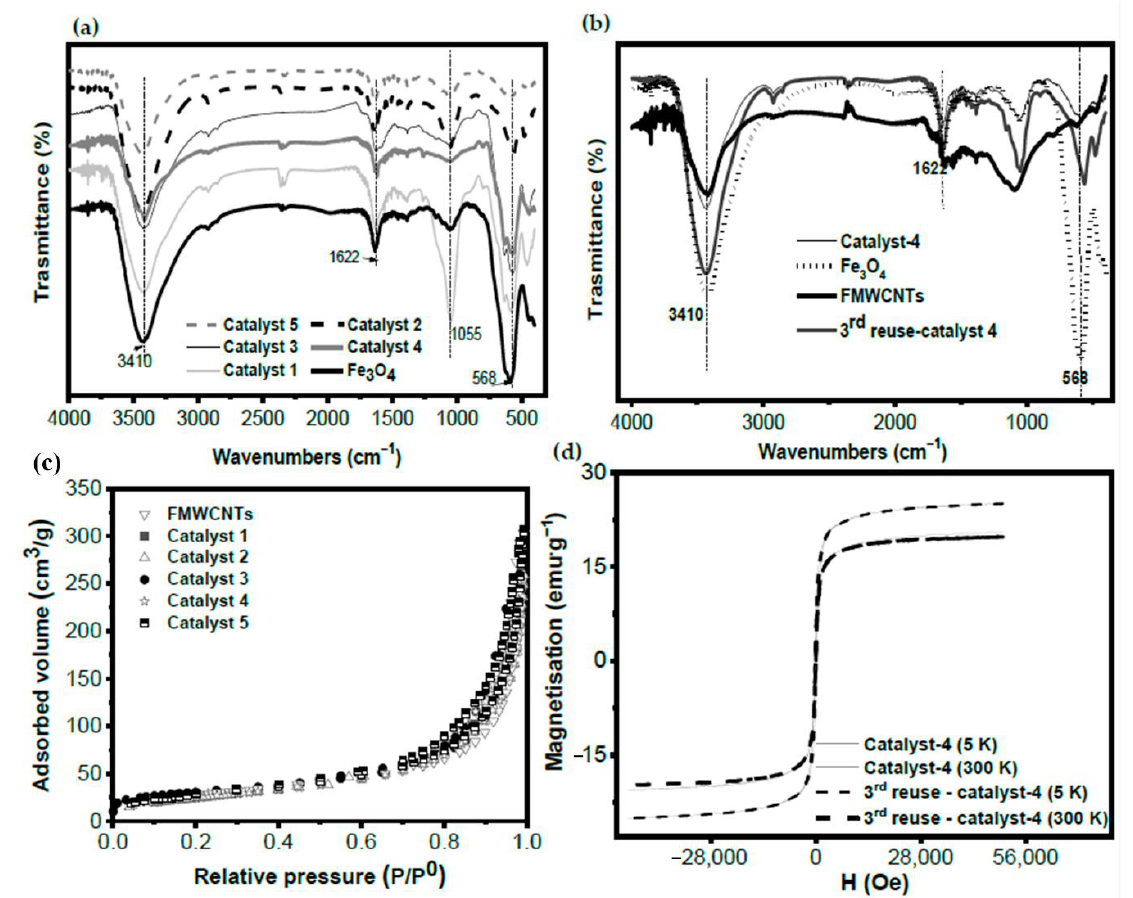
Figure 2. ( a , b ) FT-IR spectra of the FMWCNTs, Fe 3 O 4 and catalysts; ( c ) N 2 adsorption–desorption isotherms at 77 K of the FMWCNTs, and catalysts 4 and 5; ( d ) magnetic hysteresis curves of catalyst 4 and its third reuse.